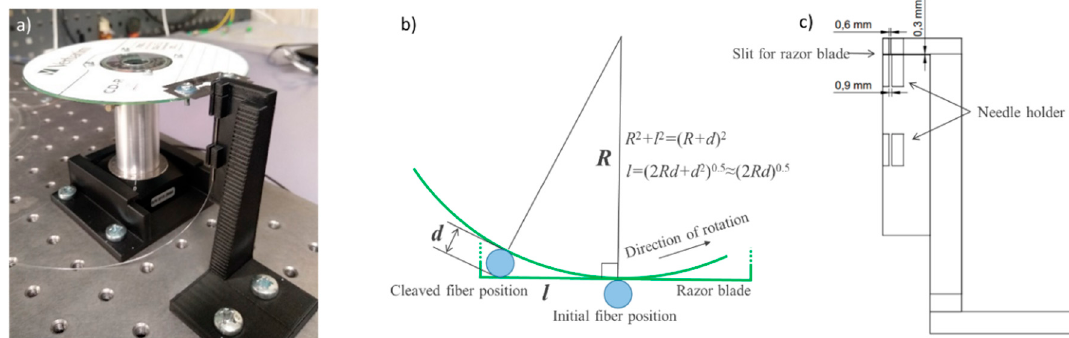
Figure 1. ( a ) A photograph of the cleaving setup based on the motorized rotational stage; ( b ) a schematic of the cleaving geometry calculation; ( c ) a drawing of the fiber holder stage.